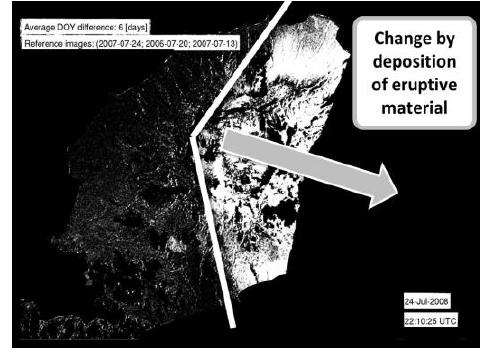
Figure 5. Log-scaled and filtered ratio image t indicating change associated with the 2008 eruption at Okmok volcano. Bright pixels where changed by ash fall and deposition of eruptive material.